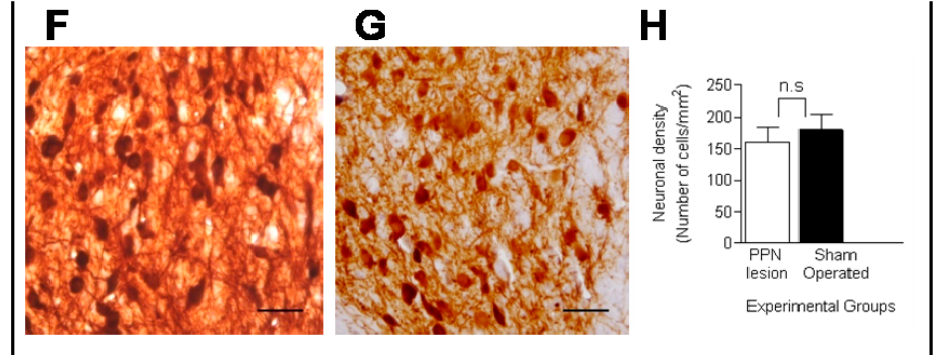
Figure 1. Morphological study. ( A , B ) Composition made from photomicrographs of brain coronal sections of a seven-day lesioned rat. ( A ) PPN area from the left side, contralateral to the lesion; ( B ) Cresyl Violet study revealed the zone of injury in the area occupied by the right PPN adjacent to the superior cerebellar peduncle (4×); ( C ) Magnification of the lesion area (10×); ( D – G ) Representative photomicrographs of the immunohistochemical study for tyrosine hydroxylase in nigral coronal sections of: Sham-operated ( D ) and NMDA-lesioned rats ( E ) (4×). The area within the rectangle of each image is magnified (40×) in ( F ) and ( G ) respectively. Note that dopaminergic cell bodies are well conserved in the SNpc on both sides; ( H ) Comparison of neuronal density showed non-significant differences between the right SNpc from NMDA-lesioned rats and Sham-operated rats groups ( n = 5 for each experimental groups). (Scale bar for D and E = 100 μ m; scale bar for F and G = 50 μ m).